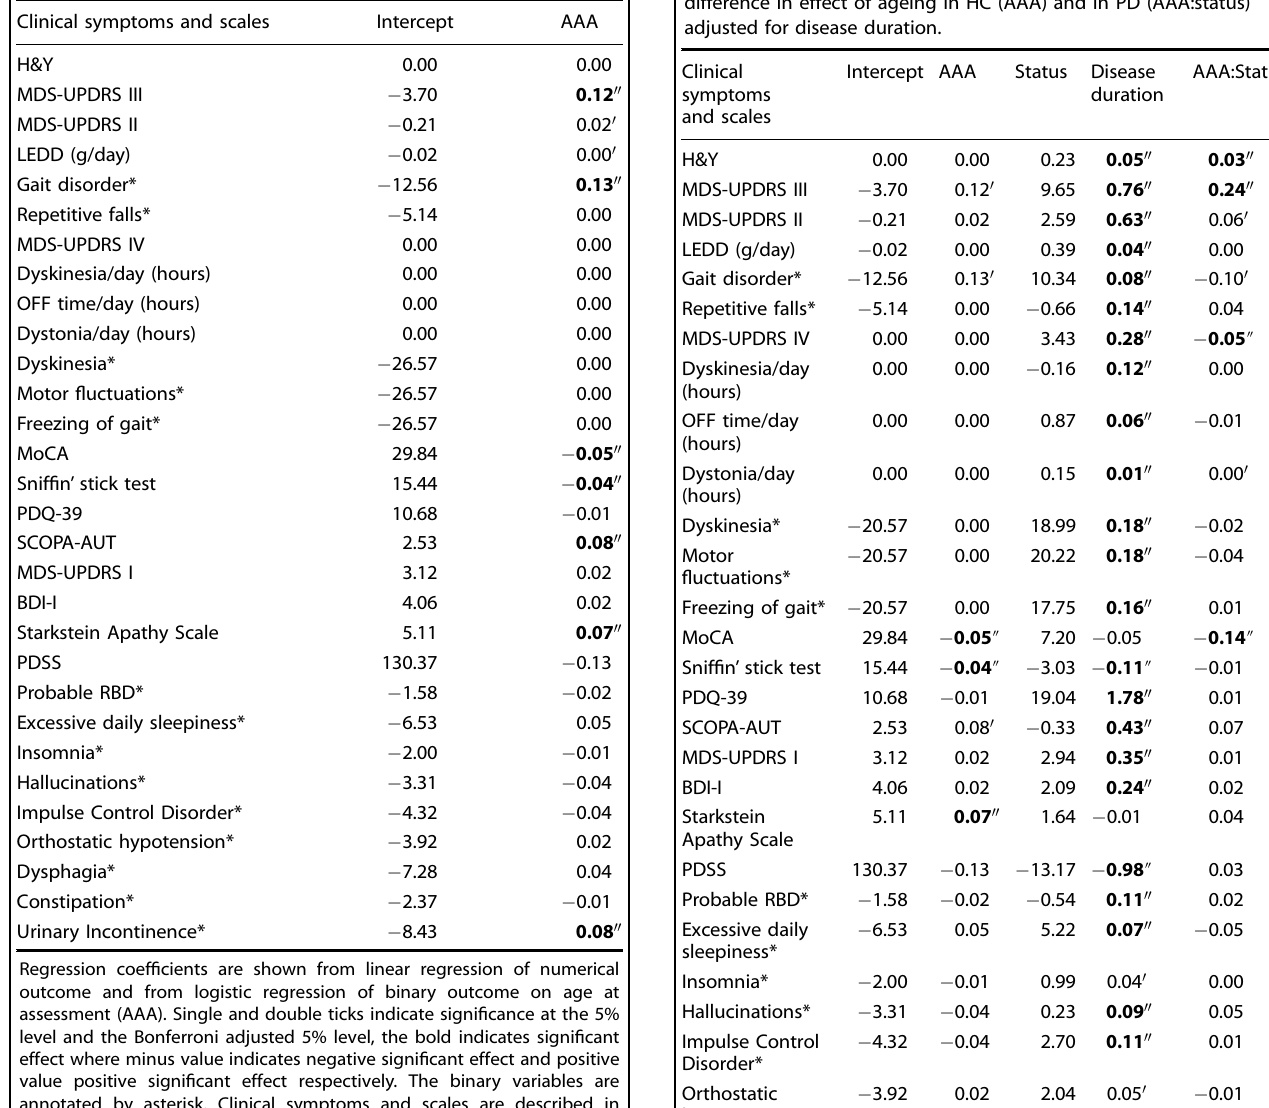
Table 4. Simple regression of clinical outcomes with healthy controls. Table 5. Multiple regression model with PD and HC investigating the